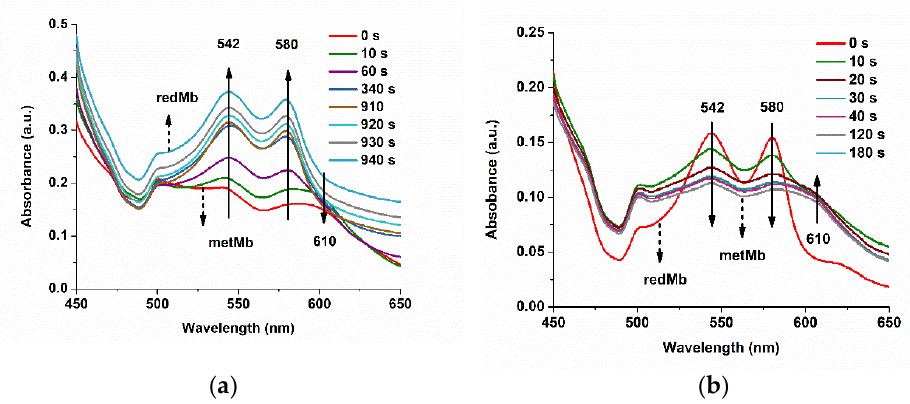
Figure 11. ( a ) UV-Vis spectra for different reaction times of 75 mM NaBH 4 and 25 µM metMb (PBS pH 9). ( b ) UV-Vis spectra for different incubation times (0, 10, 20, 30, 40, 120, and 180 s) of 100 µM PON with 10 µM redMb (PBS pH 9).